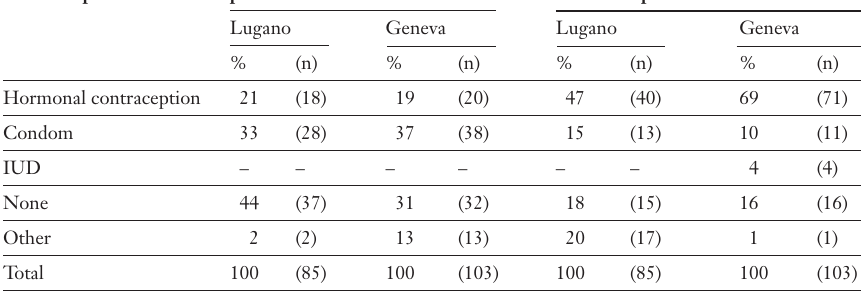
Evolution of use of contraceptive methods: comparison